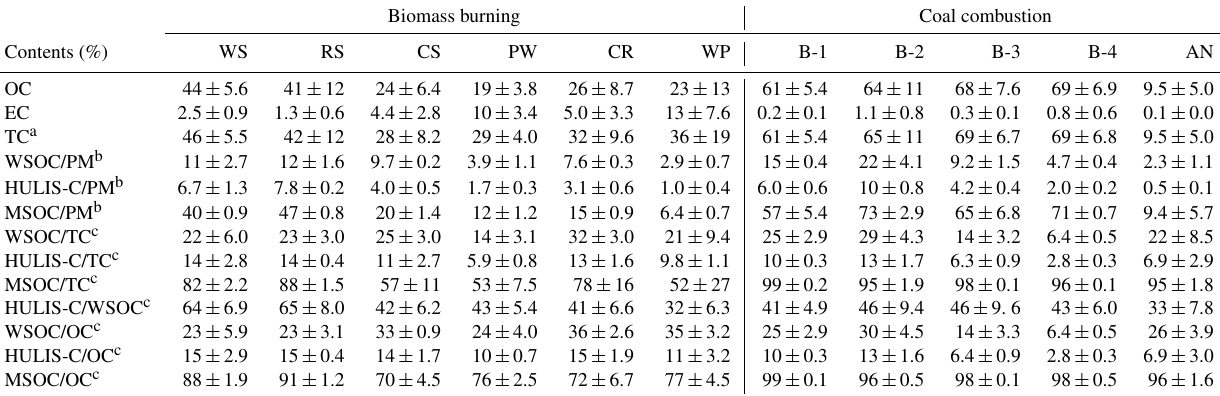
Table 1. The contributions of BrC fraction (WSOC, HULIS, and MSOC) in smoke samples (%). Biomass burning Coal combustion